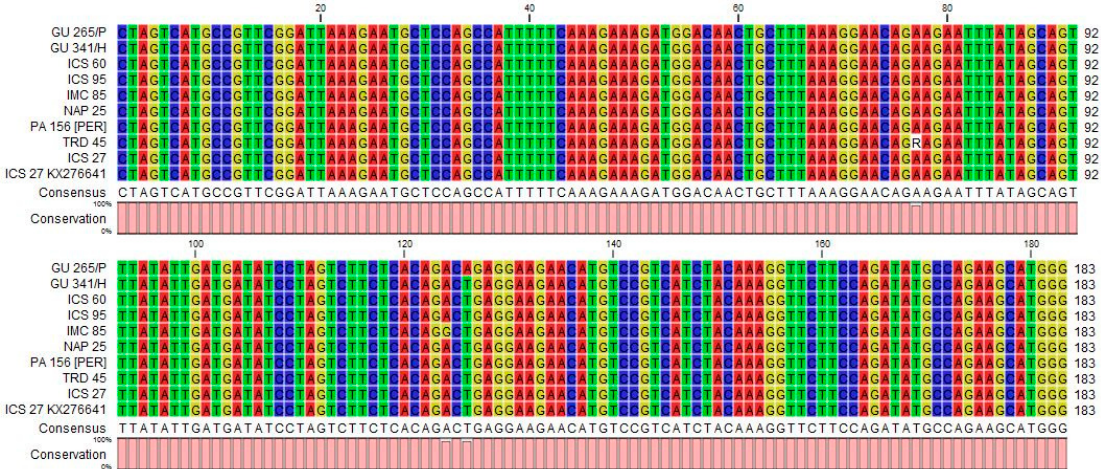
Figure 4. Alignment of 183 bp nucleotide sequences of cacao yellow vein-banding virus (CYVBV) RT-RNase H region obtained in this study from asymptomatic leaf samples from seven cocoa accessions and symptomatic sample of ICS 27 accession received from Trinidad. The CYVBV genome reported in Trinidad (KX276641, ICS 27) is used as reference sequence. The analysis was conducted using CLC sequence viewer (Qiagen, UK).